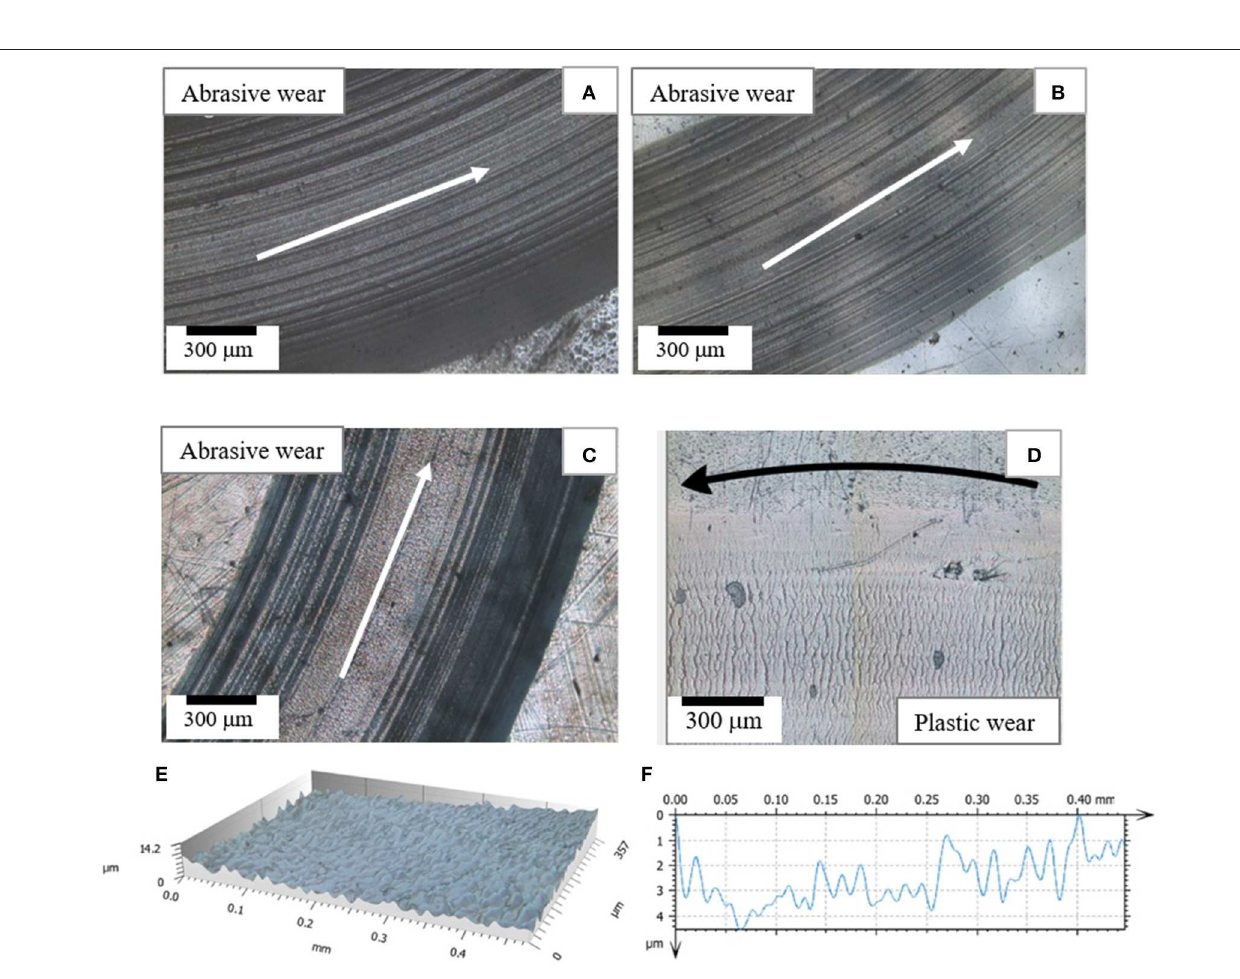
Frontiers in Materials |